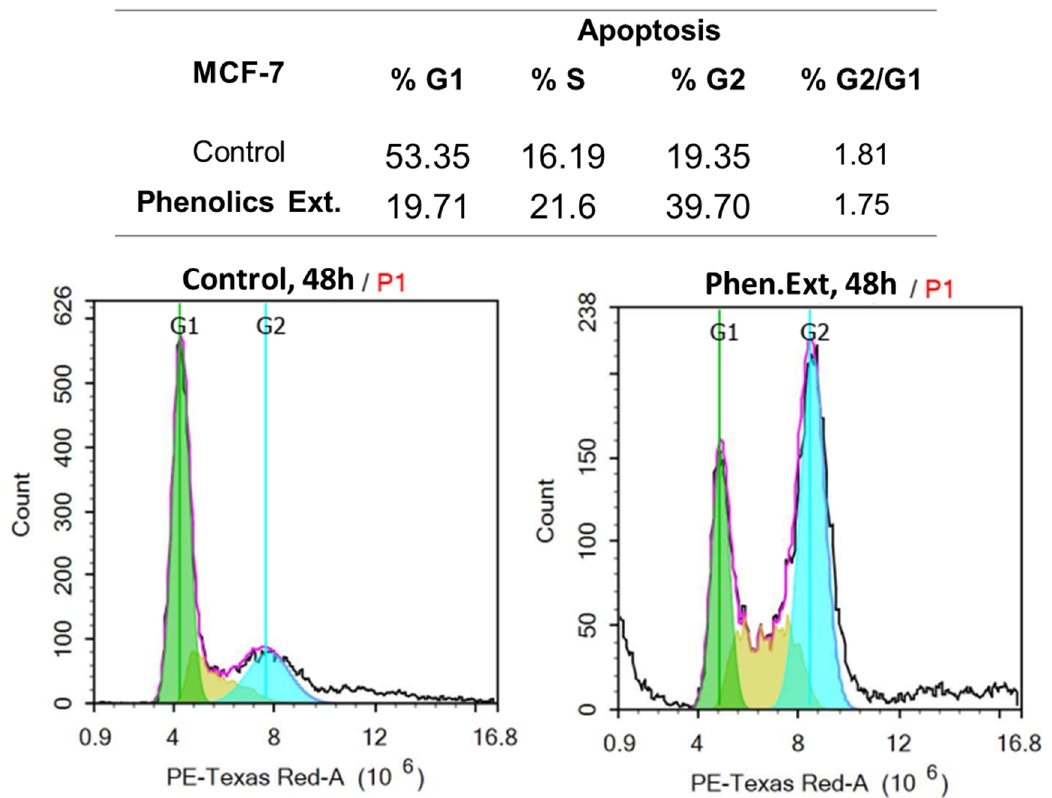
Plants 2021 , 10 , x FOR PEER REVIEW Figure 4. DNA content–flow-cytometry-aided cell cycle analyses of untreated and treated MCF-7 with the phenolic extract at IC 50 of 16.67 µg/mL, 48 h.